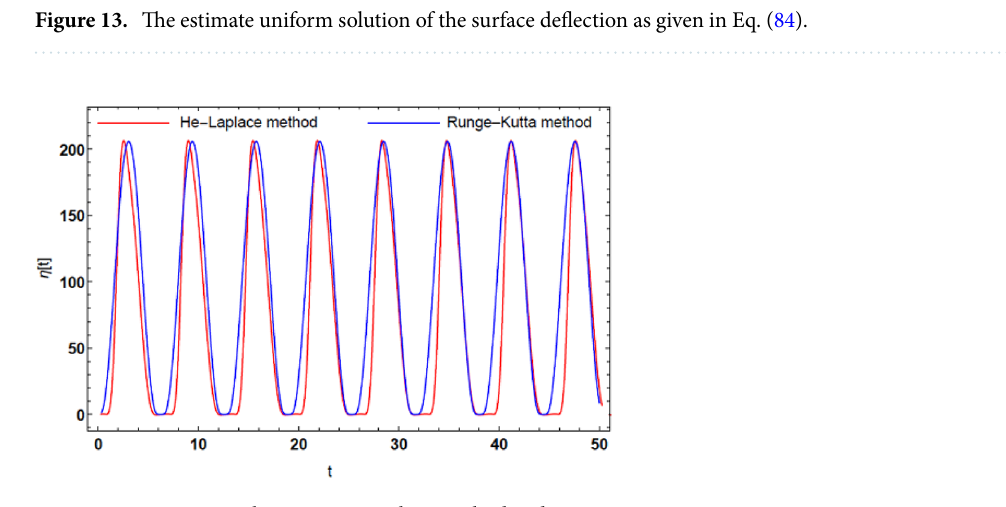
Figure 14. comparison between He-Laplace method and